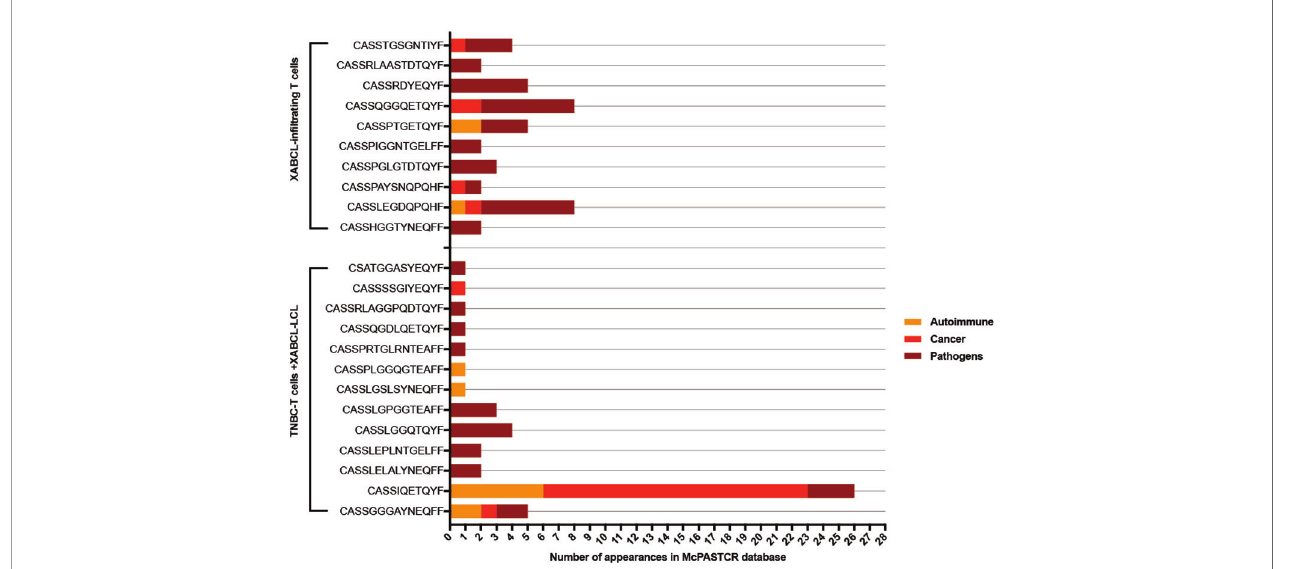
FIGURE 5 | TCR sequences from XABCL-in fi ltrating T cells and TNBC-T cells expanded in the presence of XABCL-LCL found in the McPAS-TCR database. Ten sequences from the 43 clonotypes (23%) in fi ltrating the XABCL tissue had been previously reported as TCR sequences recognizing pathogens. From these, 50% had also been described in non-communicable diseases, i.e., cancer and autoimmunity. One sequence had been identi fi ed in the three pathologies. From the T cells expanded in vitro in the presence of XABCL-LCL, 13 clonotypes were found in the literature: 8, 2, and 1 of these had been exclusively identi fi ed in pathogen infections, autoimmunity, and cancer, respectively, and 2 sequences had been described in the three categories, but remarkably the CASSIQETQYF sequence had been identi fi ed several times in